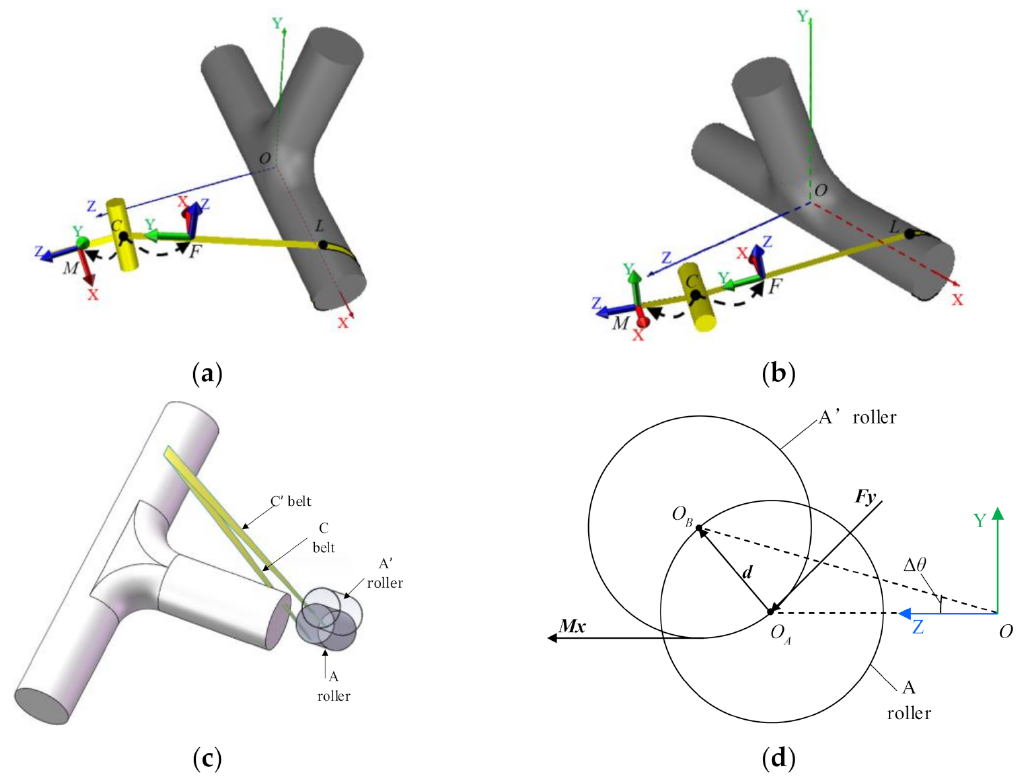
Figure 9. Interferences in four and five-coordinate system: ( a ) Four coordinate system; ( b ) Five coordinate system; ( c ) Hanging yarn corresponding to yarn exit positions; ( d ) Position